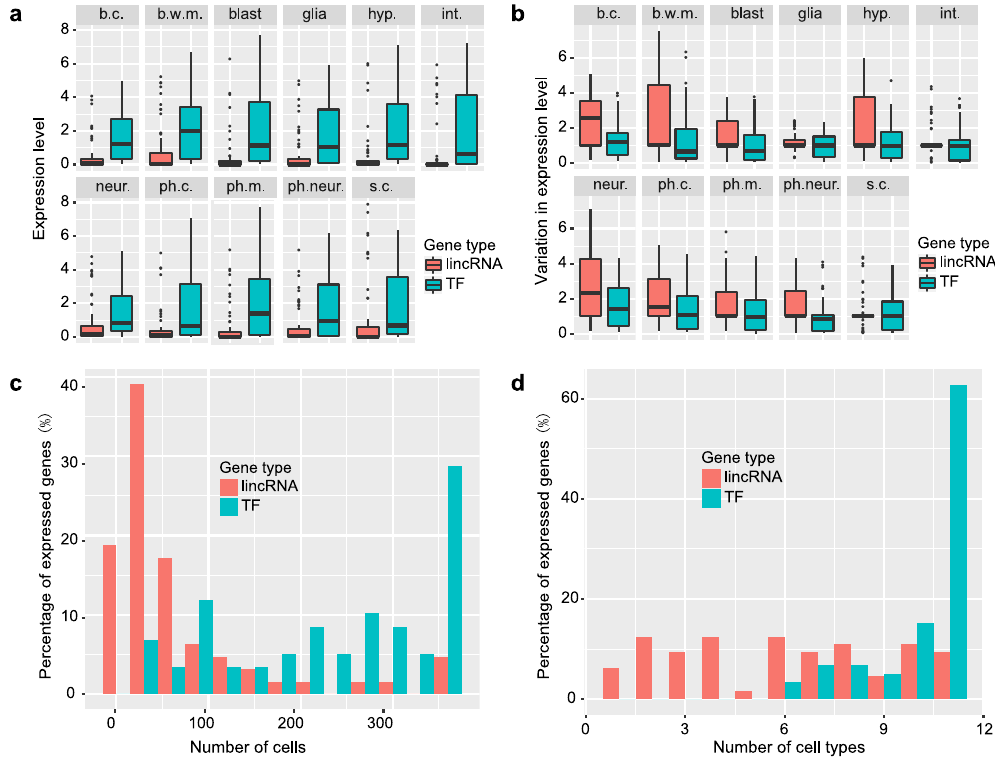
Figure 2. Comparison of expression features of lincRNA and TF reporters. ( a , b ) Expression level ( a ) and the coefficient of variation in expression level ( b ) of lincRNA and TF reporters in each cell type (CV is calculated as the the ratio of the standard deviation σ to the mean μ ). Cell type abbreviation is the same as in Fig. 1. Error bars equal SEM. ( c , d ) Distribution of the number of cells ( c ) and cell types ( d ) in which lincRNA or TF reporters are